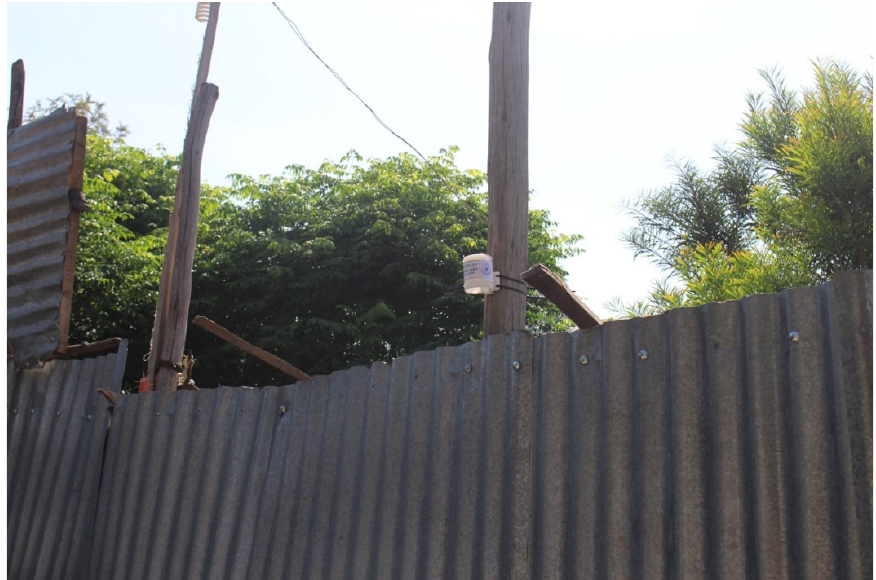
Figure 2. Photo of Ogawa badge in its rain protection from one of the NO x and NO 2 sampling sites.